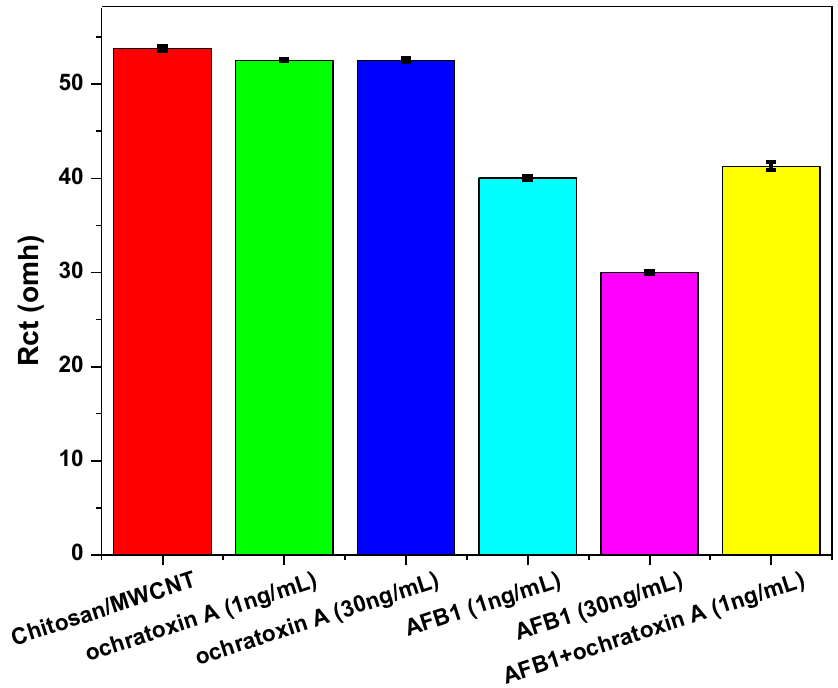
Figure 7. R ct values for the chitosan/MWCNT and chitosan/MWCNT with immobilized anti-AFB1 immunosensor in the presence of interfering mycotoxin (ochratoxin A).